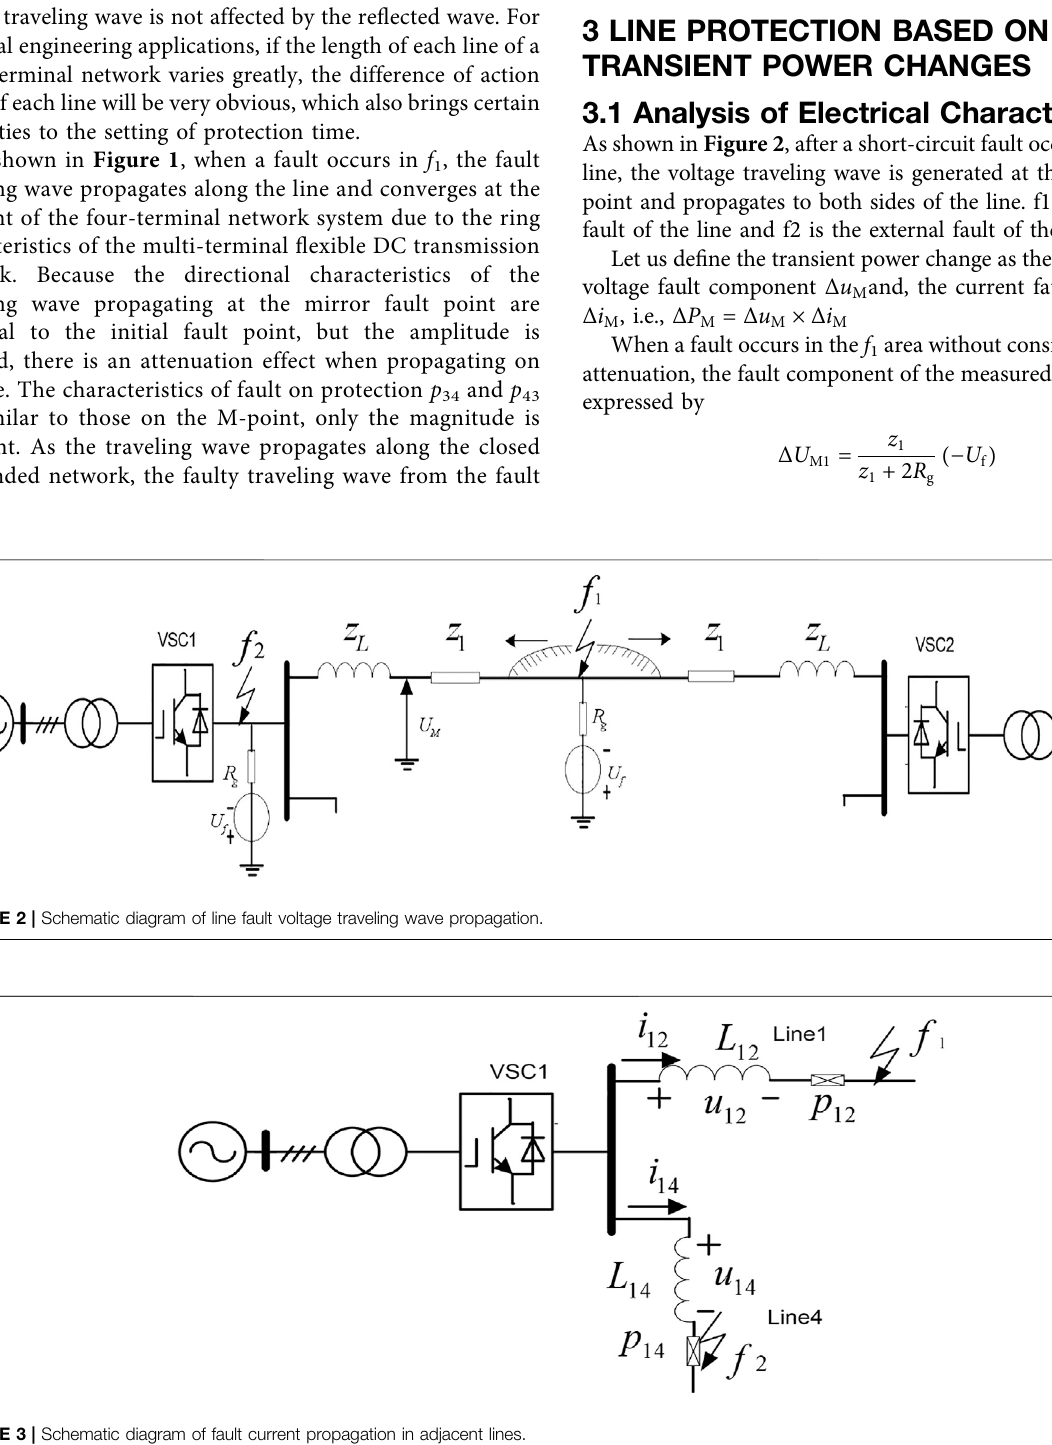
FIGURE 3 | Schematic diagram of fault current propagation in adjacent